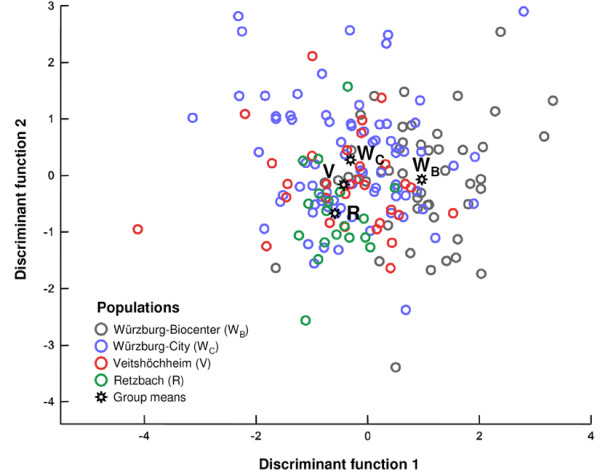
Discriminant analysis of geographical variation of the sex-pheromone on the local scale. Despite broad overlap, the populations are significantly separated (data set 1, four subpopulations, C25-type only; see Table 1 and text for details).